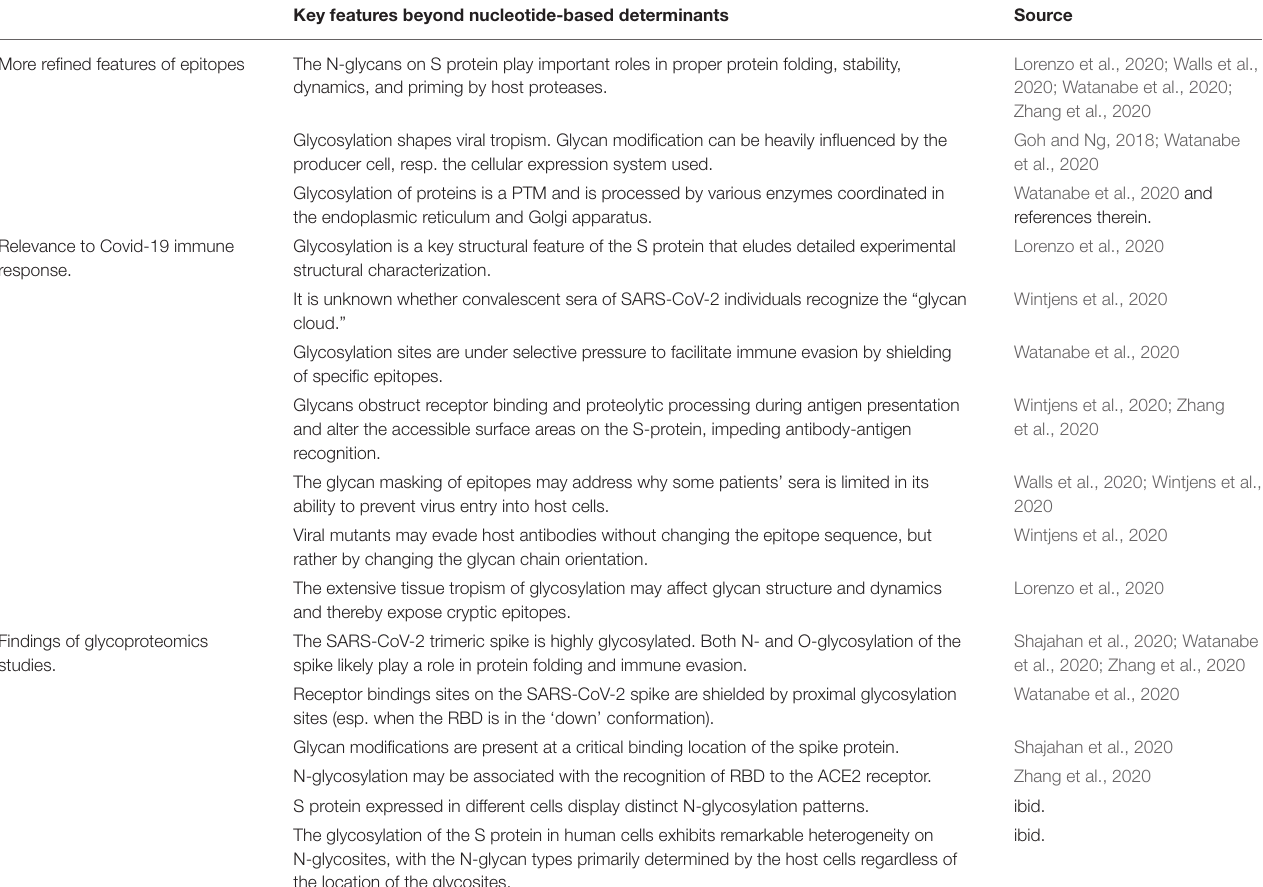
TABLE 3 | The importance of glycans in coronaviruses with special focus on